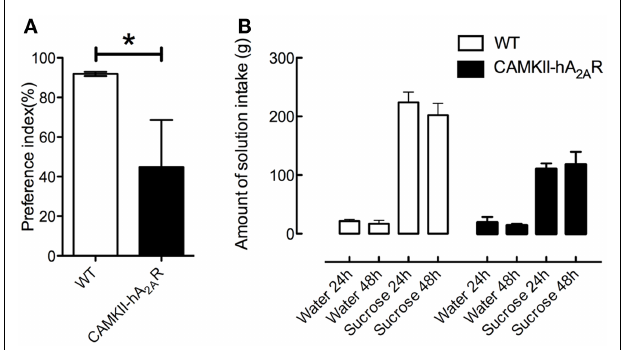
FIGURE 5 | Sucrose preference test . (A) Preference index at 48h and (B) control of amount of solution intake. Results are expressed as